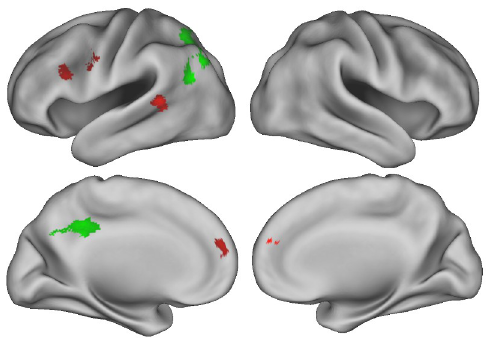
Fig 1. This figure depicts the fMRI results for the stimulus-independent thought versus external focus contrast with FWE cluster-wise correction. Regions colored in green were activated across age groups during stimulus- independent thought versus external attention whereas young adults had greater recruitment of red regions compared to older